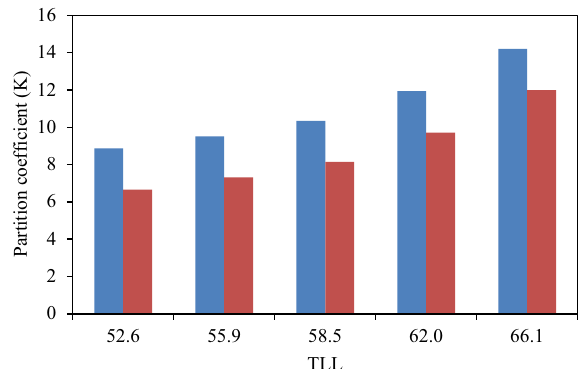
Figure 2. Partition coefficient, K , in function of the TLL for each studied drug in ATPS {KOH + PEG 600 + H 2 O}. Ibuprofen Acetaminophen .